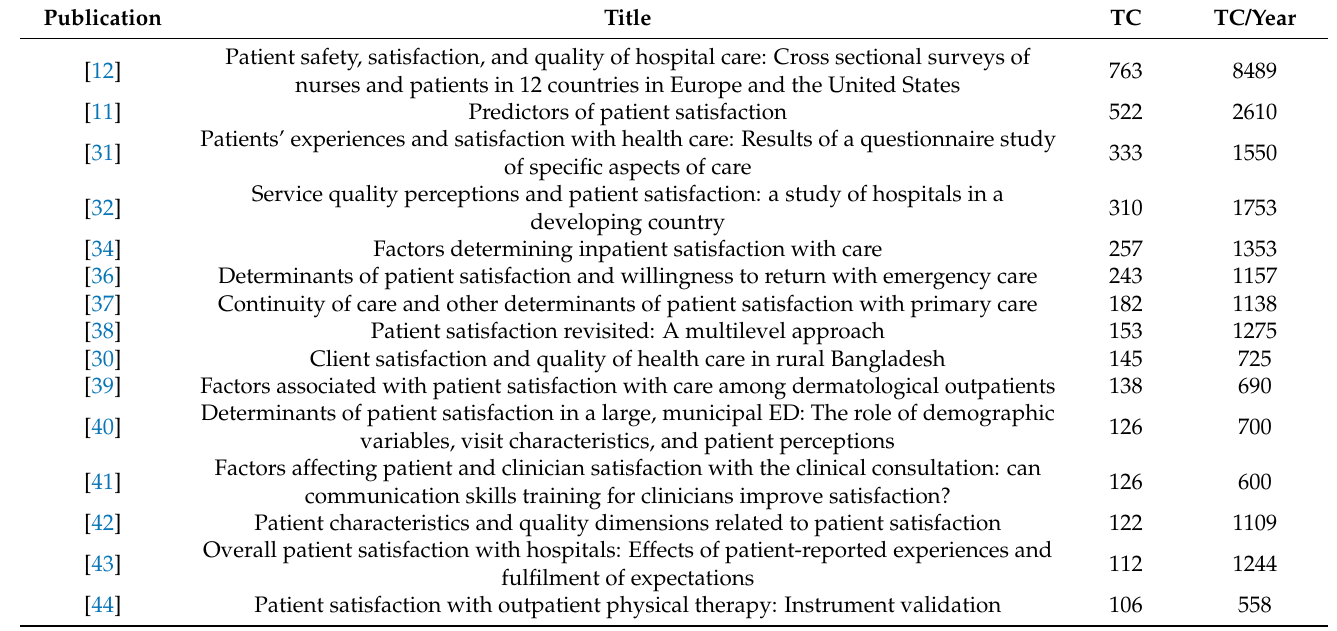
Table 6. Total citations (TC) and TC/year of the fifteen most cited publications.